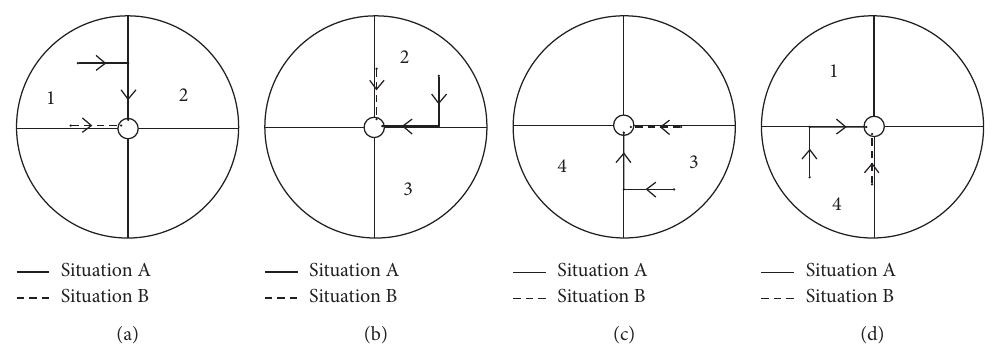
Figure 4: Light spot movement track. (a) Spot in the first quadrant. (b) Spot in the second quadrant. (c) Spot in the third quadrant. (d) Spot in the fourth quadrant.